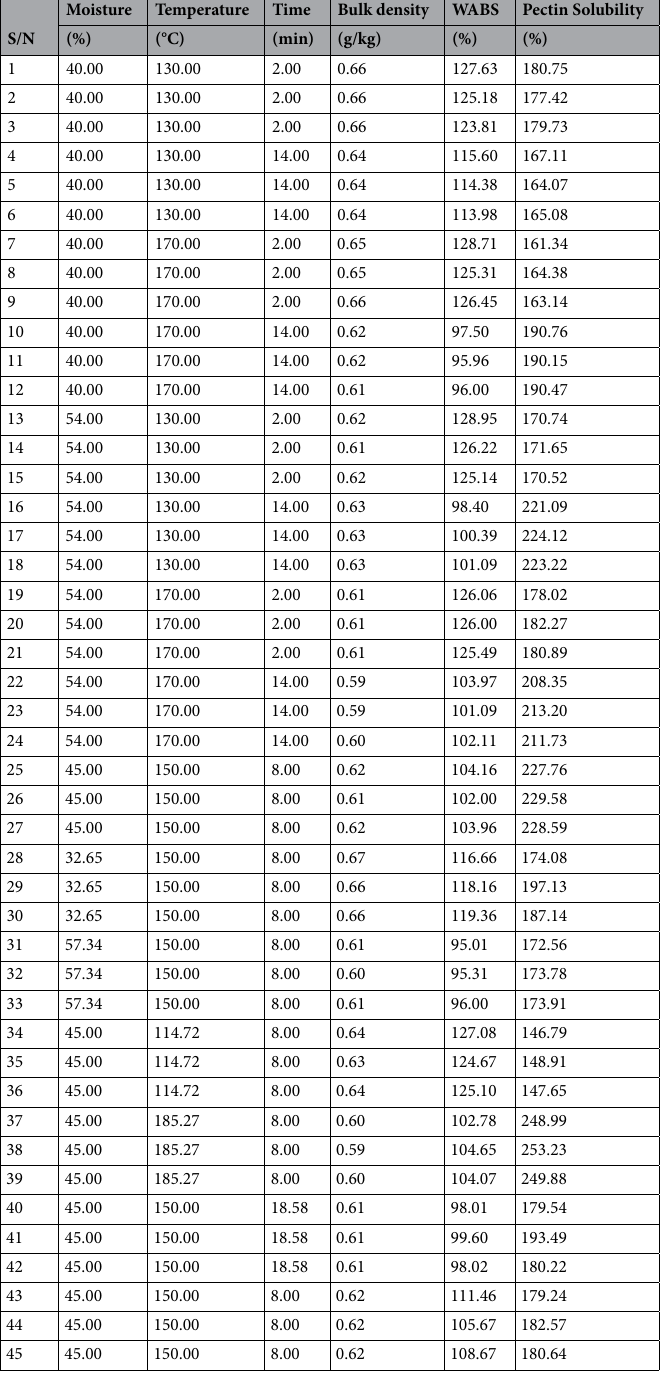
Table 2. Experimental raw input